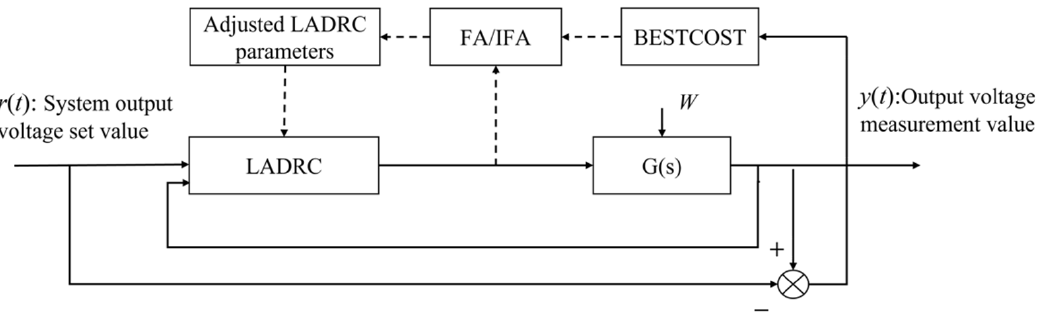
Figure 5. LADRC structure diagram of SOFC system.